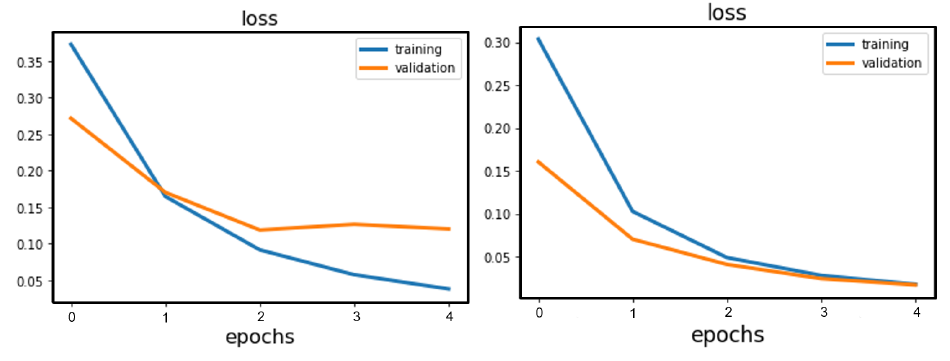
Figure 12. Loss curves for damage detection models 1 ( left ) and 2 ( right